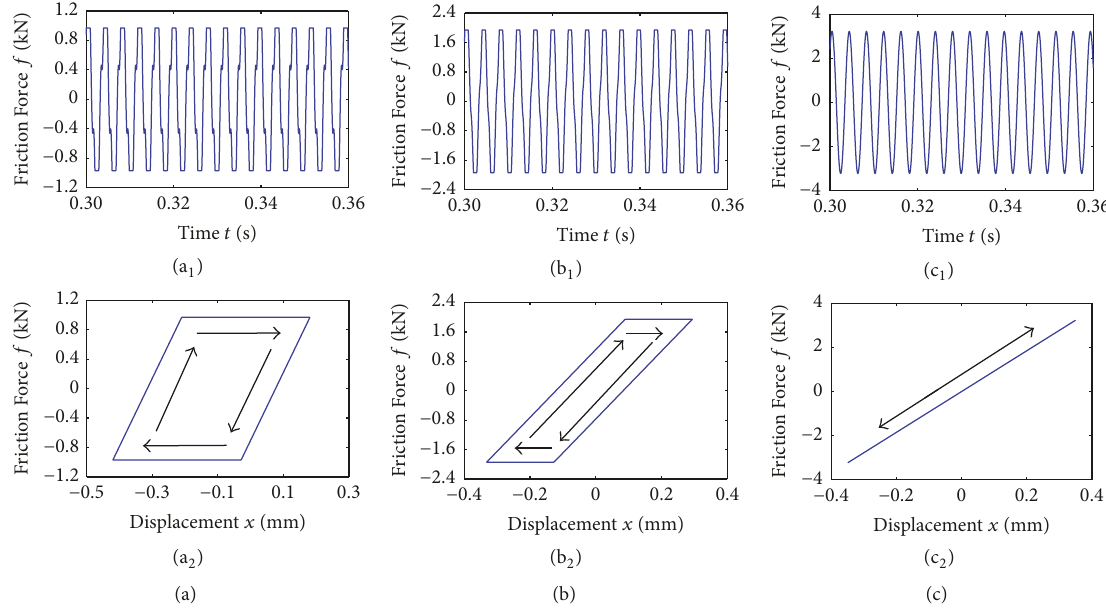
Figure 8: The variation curves of dry friction force at different friction coefficients (subscript 1 represents the variation curve of dry friction force and subscript 2 represents the hysteresis